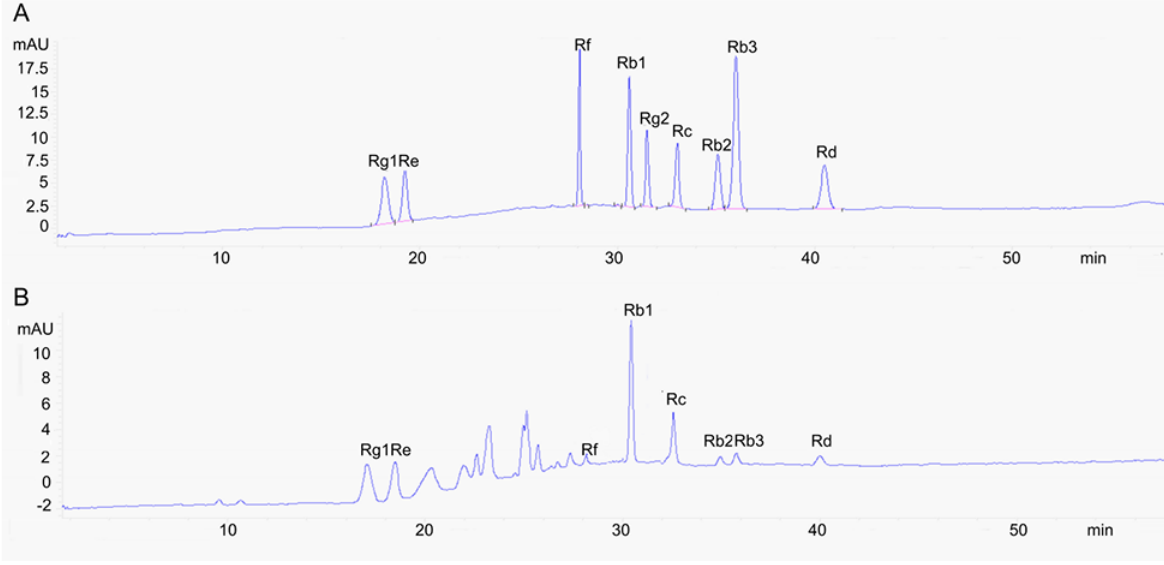
Fig. 2 The representative chromatogram of standards and RCL extract. Rg1, Re, Rf, and Rg2 protopanaxatriol derivatives (ginsenosides of Rg group); Rb1, Rb2, Rc, Rb3, and Rd protopanaxadiol derivatives (ginsenosides of Rb group).